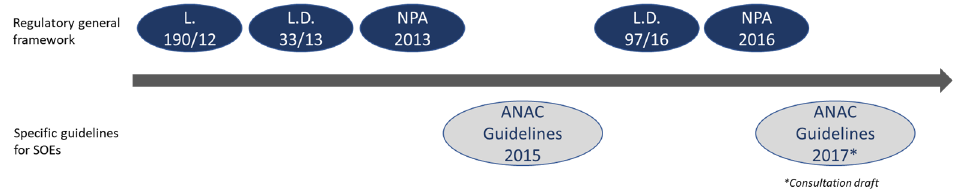
Figure 1: Transparency: the Evolution of Italian Legislation for